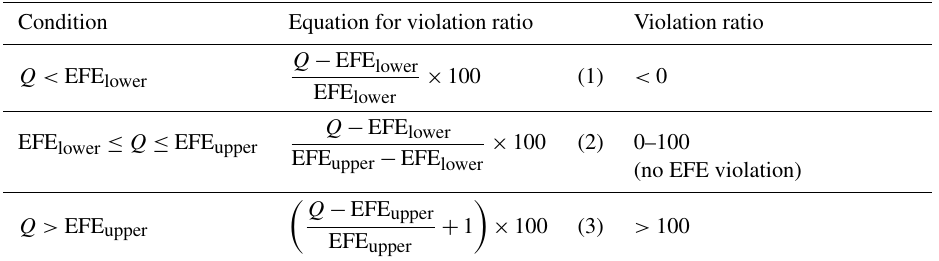
Table 2. Computing the EFE violation ratio. Q stands for monthly discharge between 1976 and 2005; EFE lower for the EFE lower bound, and EFE upper for the EFE upper